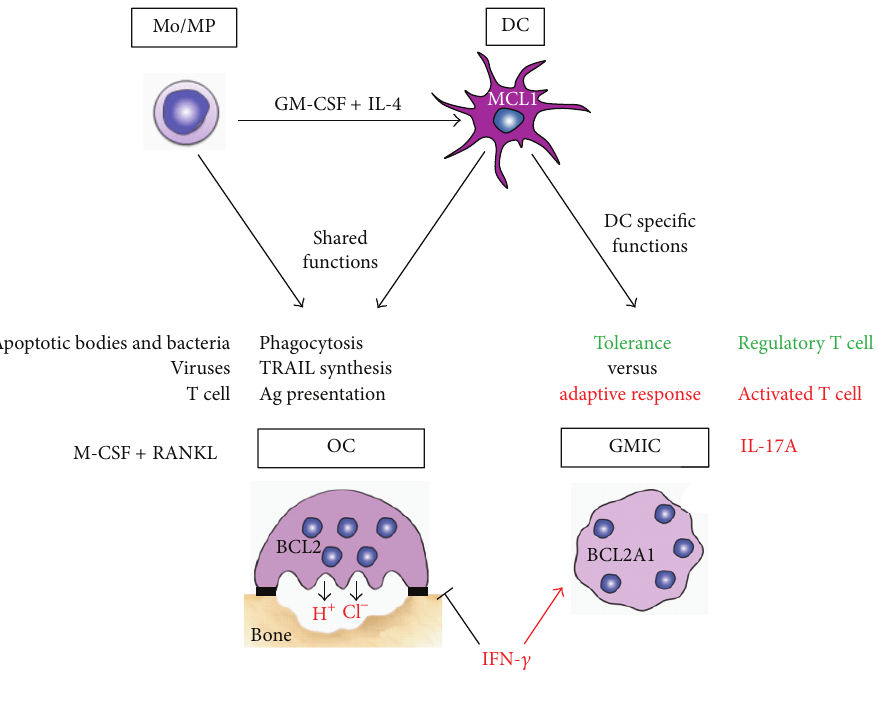
Figure 1: Dendritic cell functions compared to monocytes. Monocyte-derived DCs share four functions with monocytes: phagocytosis, TRAIL synthesis, Ag presentation, and differentiation into OC in the presence of M-CSF and RANKL. Conversely, initiation of tolerance, adaptive response, and IL-17A-dependent differentiation of GMIC are DC-specific functions. IFN- 𝛾 differentially regulates MGC formation by inhibiting OC and stimulating GMIC